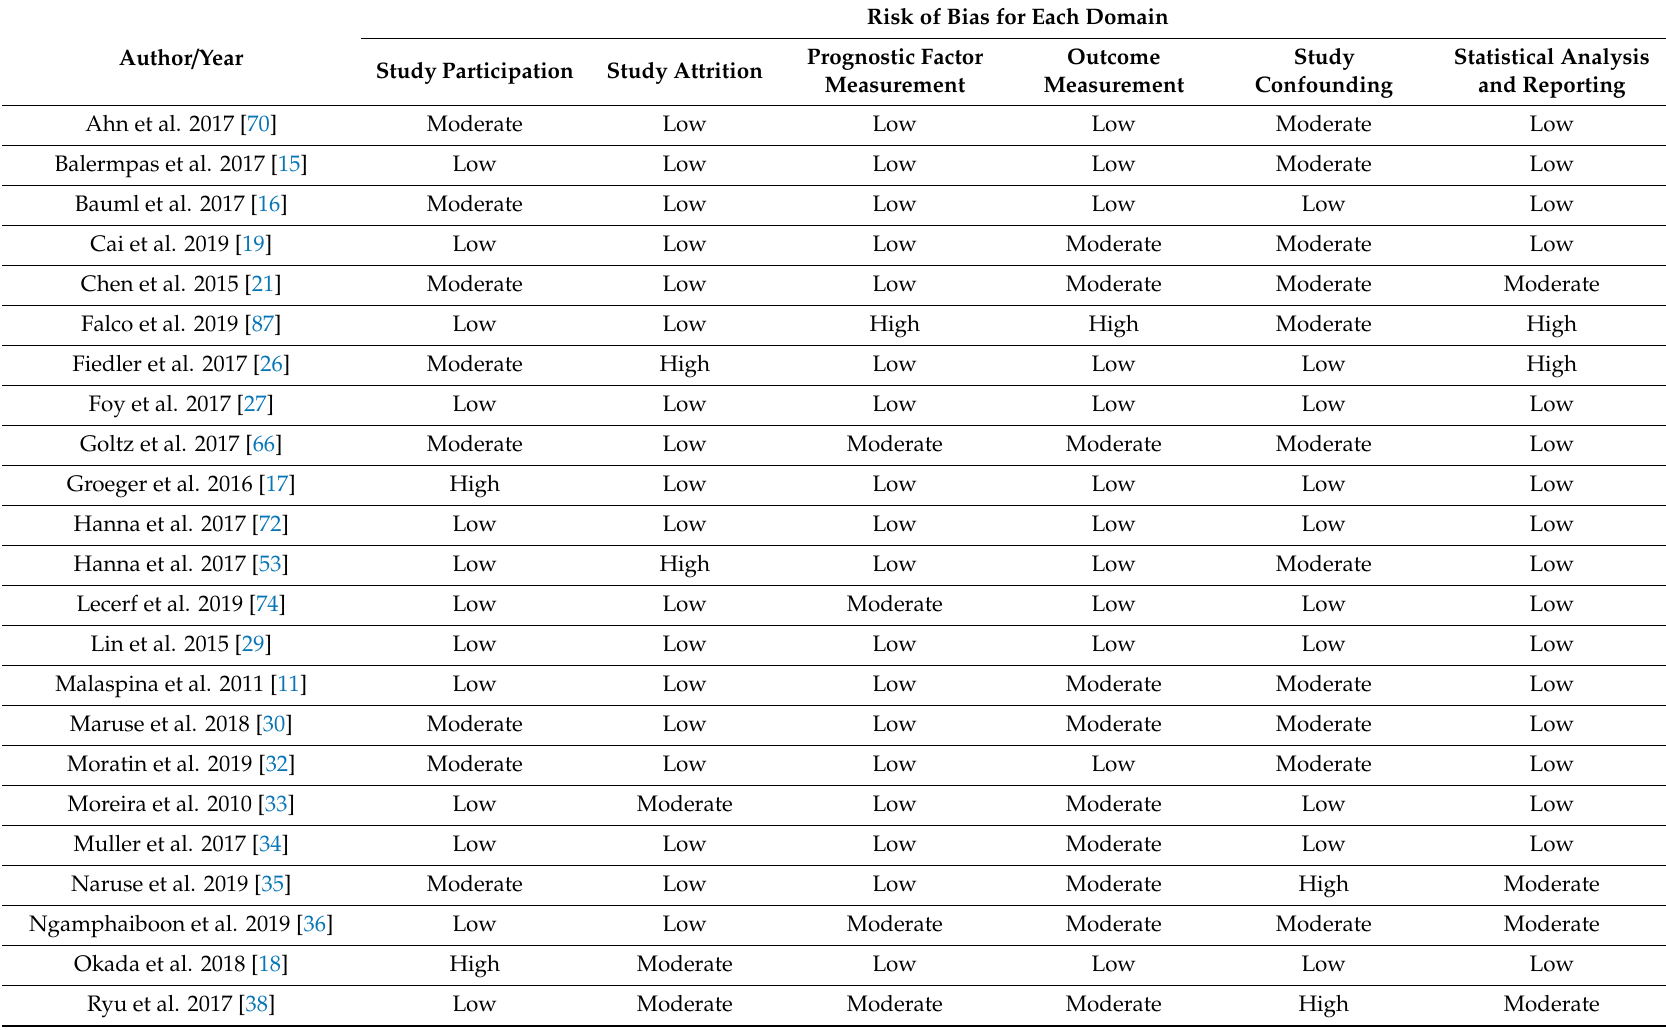
Table 3. Quality Assessment of Studies of Prognostic Factors Using the Quality In Prognosis Studies QUIPS